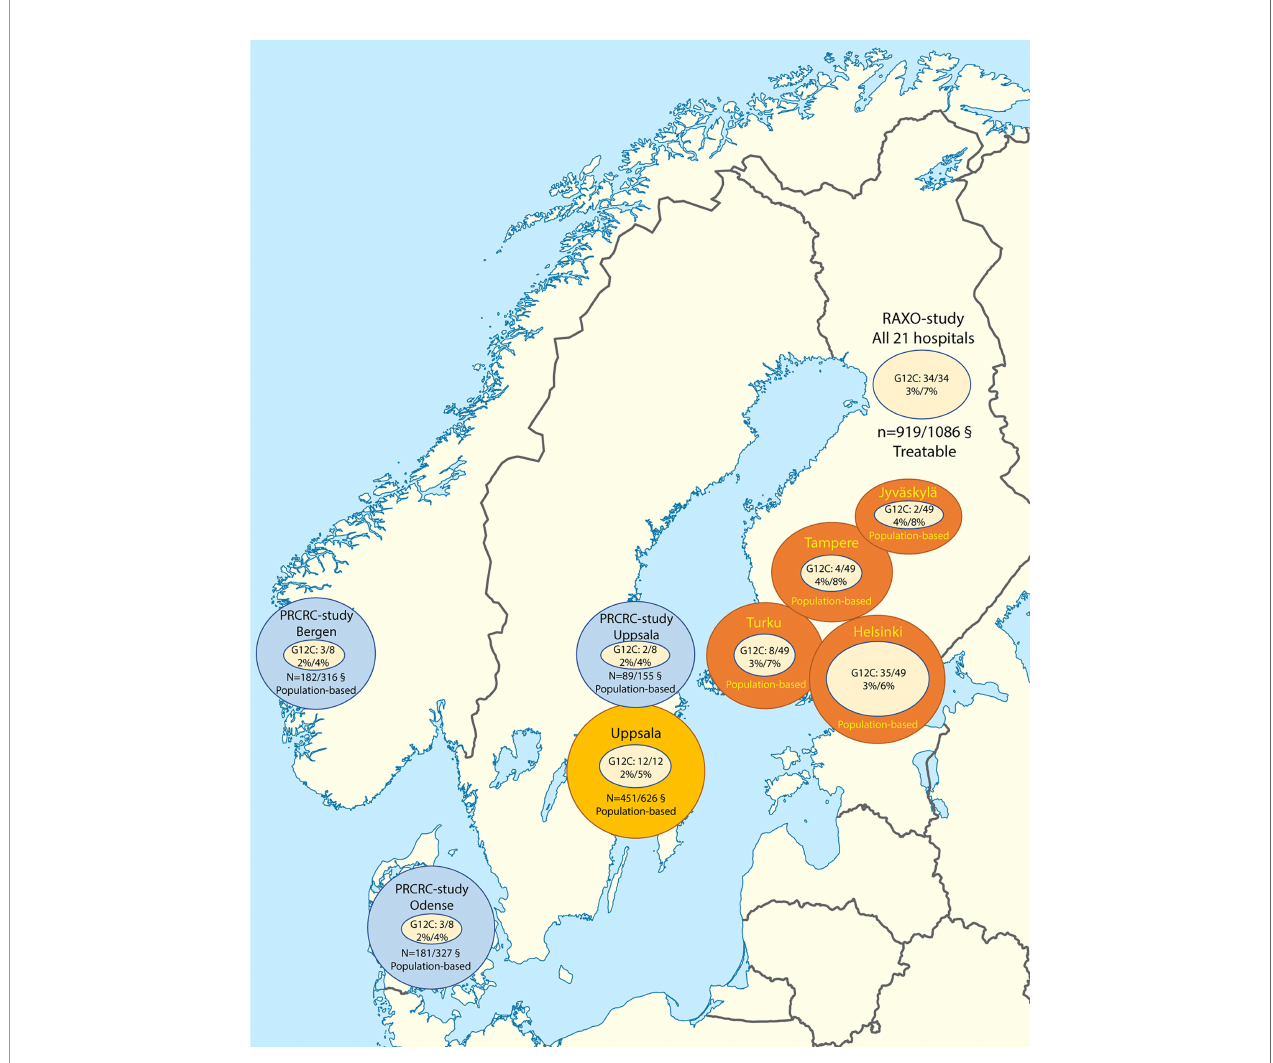
FIGURE 1 | Patient inclusion in the Nordic cohorts including KRAS -G12C mutation rates per all tested (at least KRAS ) tumors and among all KRAS - mutated tumors. § Adequately grouped KRAS , NRAS , and BRAF- V600E status/study